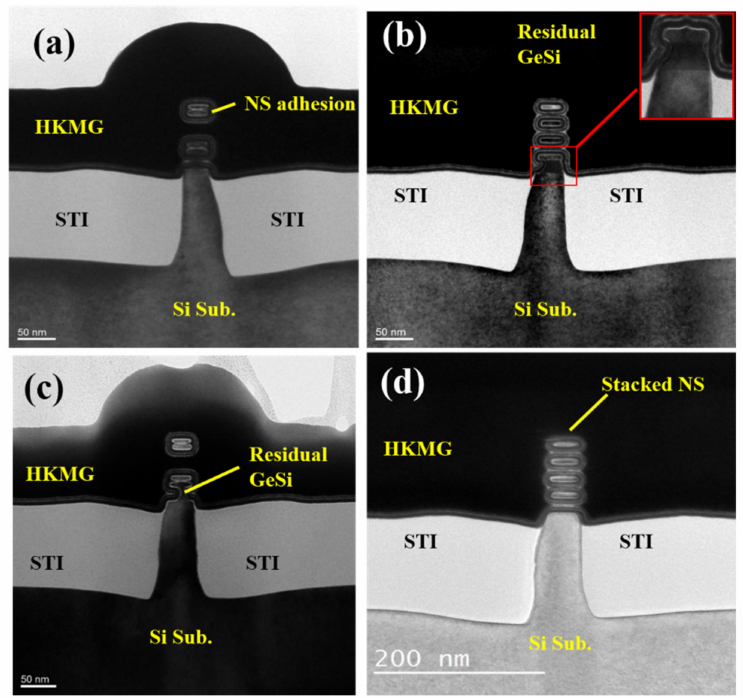
Figure 8. Cross-sectional TEM images of stacked GAA Si NS channel with ( a ) NS channels sticking to each other, ( b ) the residual of the bottom GeSi, ( c ) NSs channels sticking to each other and a thin residual of the bottom GeSi, and ( d ) complete NS